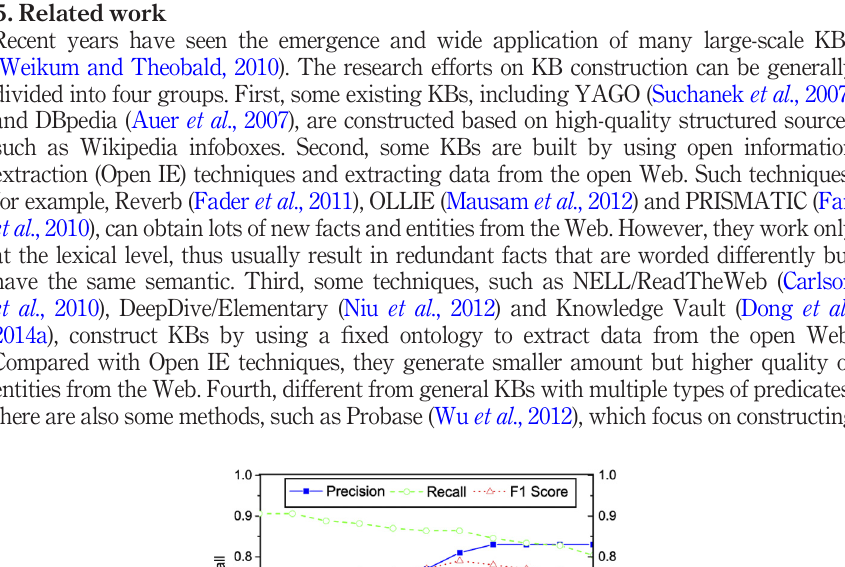
graph-based truth discovery approach under varying source con fi dence factor, i.e.